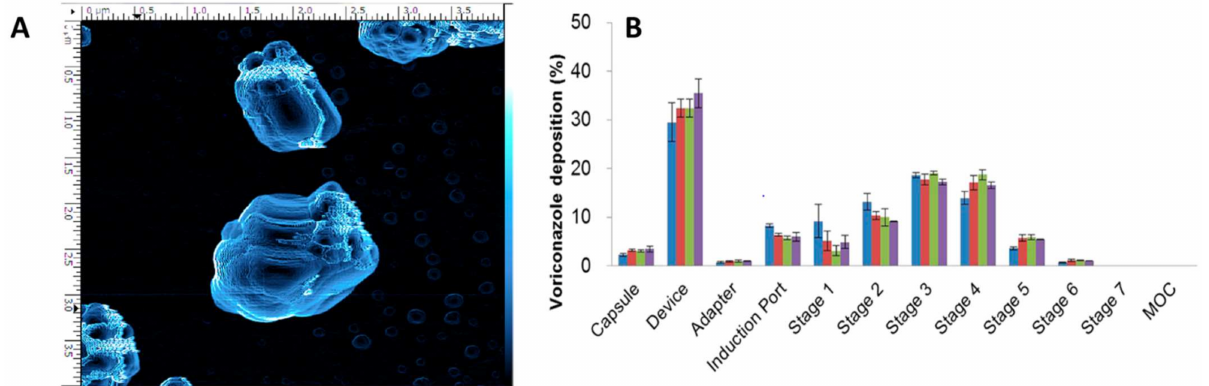
Figure 4. ( A ) AFM topography image of aerosolized TFF-VCZ-MAN 95:5 by DP4 insufflator; ( B ) Aero- dynamic particle size distribution profile of TFFVCZ-MAN 95:5 by time sheared: (blue) at 0 min; (red) at 15 min; (green) at 30 min; (purple) at 60 min ( n = 3; mean ± SD). Reproduced from Moon et al. [27] with kind permission of copyright holder, American Chemical